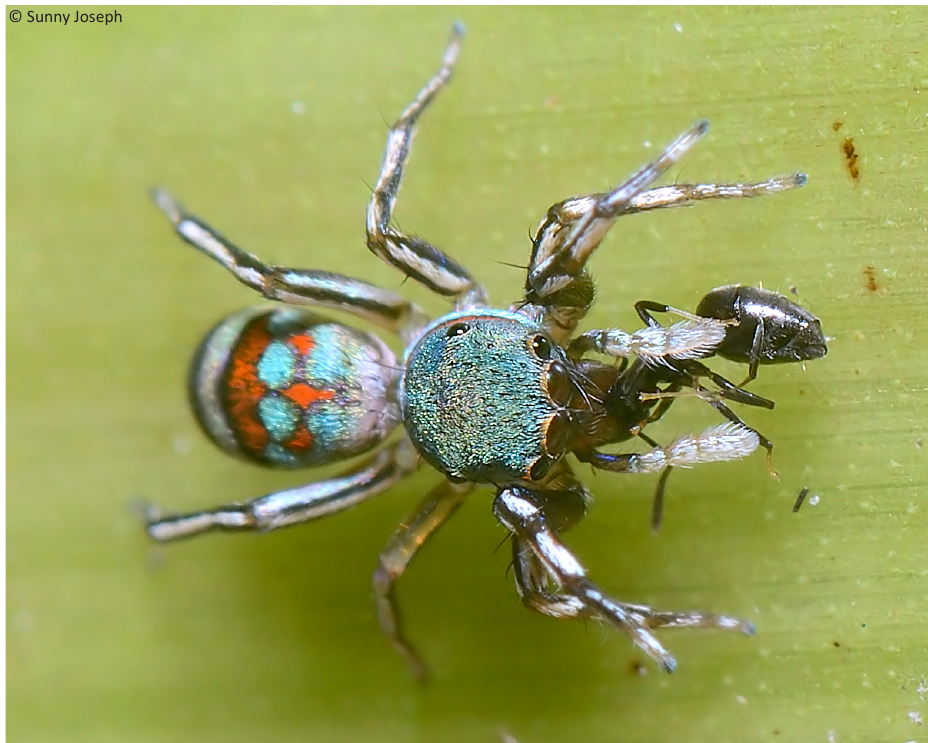
Image 4. Siler semiglaucus feeding on Technimyrmex sp.